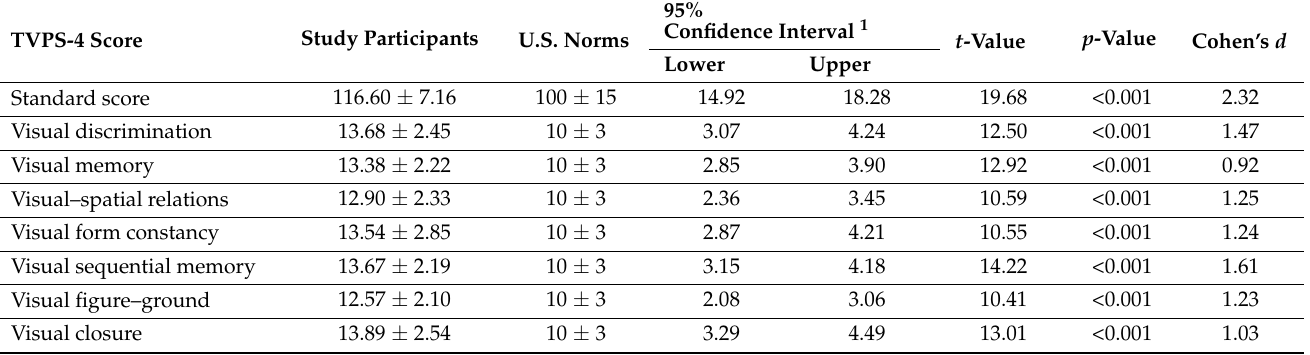
Table 3. Comparison between the study participants and the U.S. norms for TVPS-4 standard score (normative mean: 100 ± 15) and scaled scores (normative mean: 10 ±